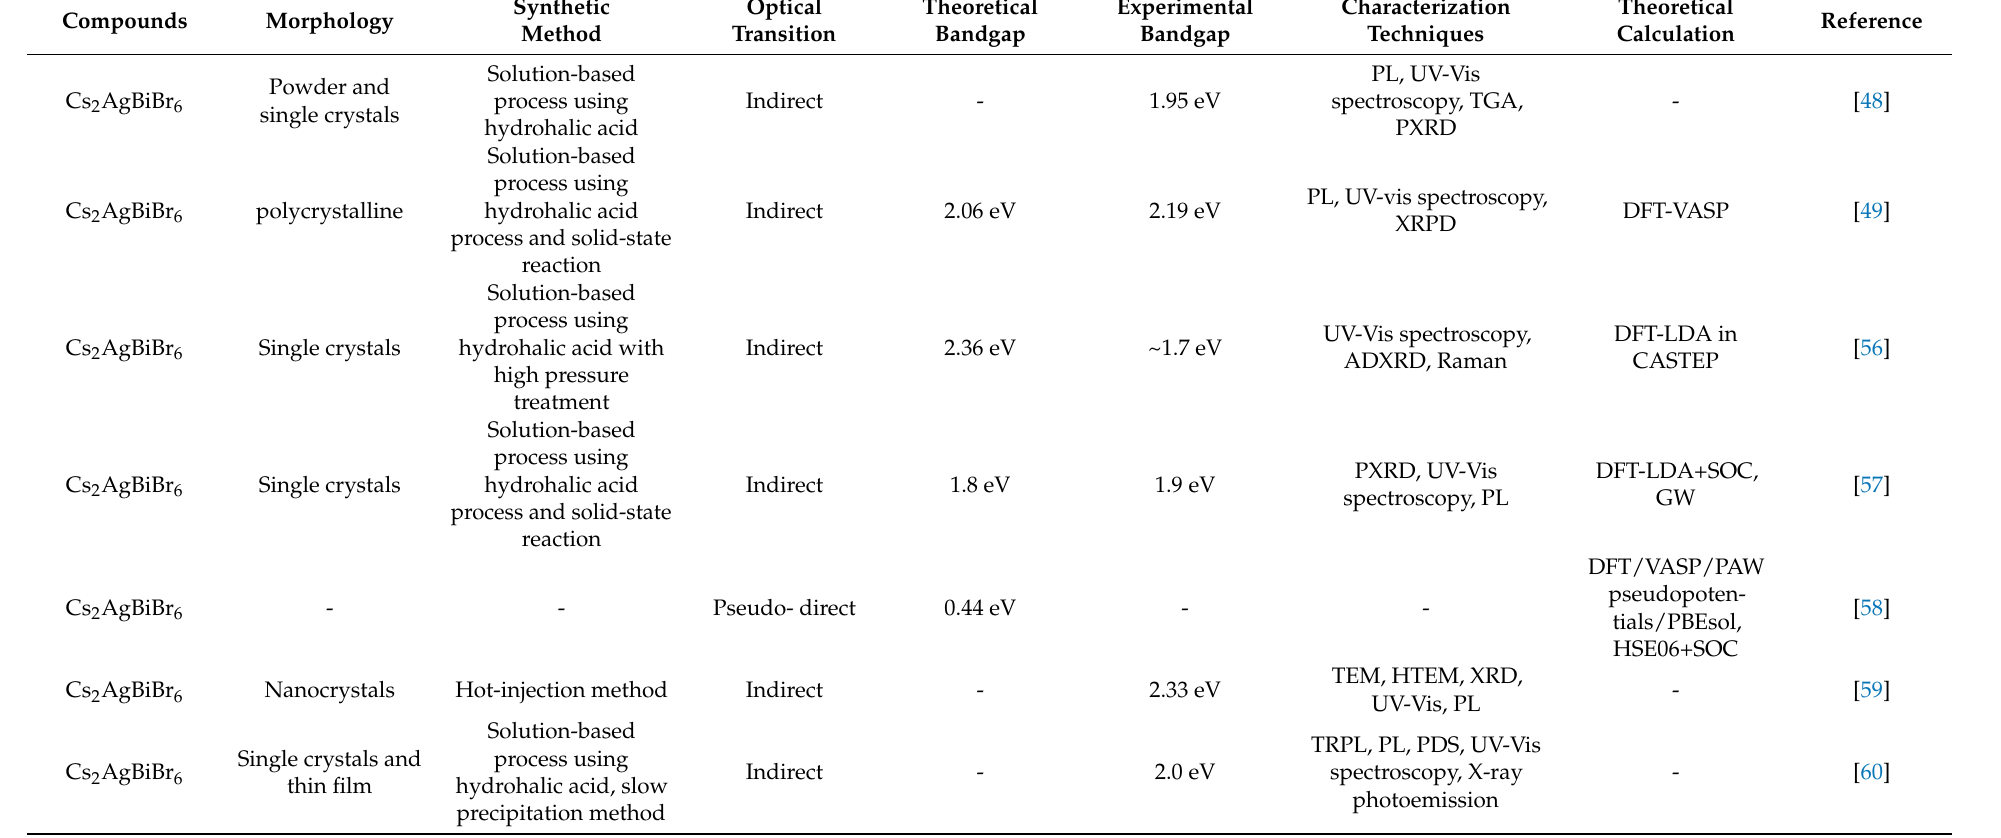
Table 1. Summary of prepared double halide perovskite samples based on inorganic Cs/Bi 3+